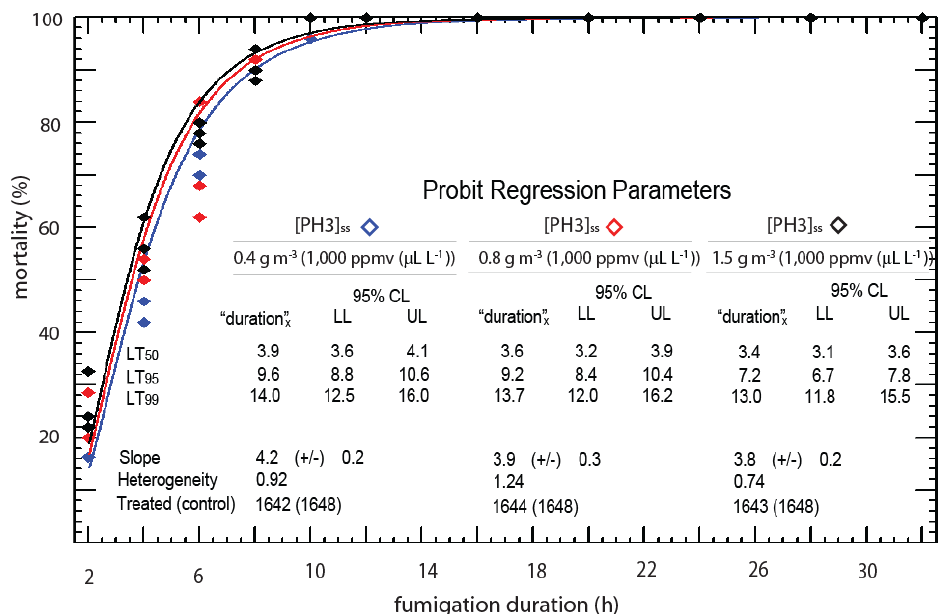
Figure 1. Mortality of adult bean thrips (BT), Caliothrips fasciatus (Pergande), adults following fumigation with 1.6% phosphine by volume in nitrogen at air temperature 4.9 ± 0.3 ◦ C ( x ± 2 s ) and probit regression analyses (Polo Plus, LeOra Software, 2002–2007) of the duration–mortality response respective to applied doses and steady-state headspace concentrations, [PH 3 ] ss of 0.4 (250), 0.8 (500), and 1.5 g m − 3 (1000 ppmv ( µ L L − 1 )), showing the number of specimens treated, non-fumigated control specimens, the regression heterogeneity (H), the projected durations to cause 50 , 95, and 99% mortality in the treated population (respectively LT 50, LT 90 , and LT 99 ), and the corresponding estimates of the bounds (upper (UL) and lower (LL) limits) at the 95% confidence level (CL). Lethal time ratios (LTRs), where the response to [PH 3 ] ss of 0.4 g m − 3 (250 ppmv ( µ L L − 1 )) was normalized to that of 0.8 g m − 3 (500 ppmv ( µ LL − 1 )) or 1.5 g m −